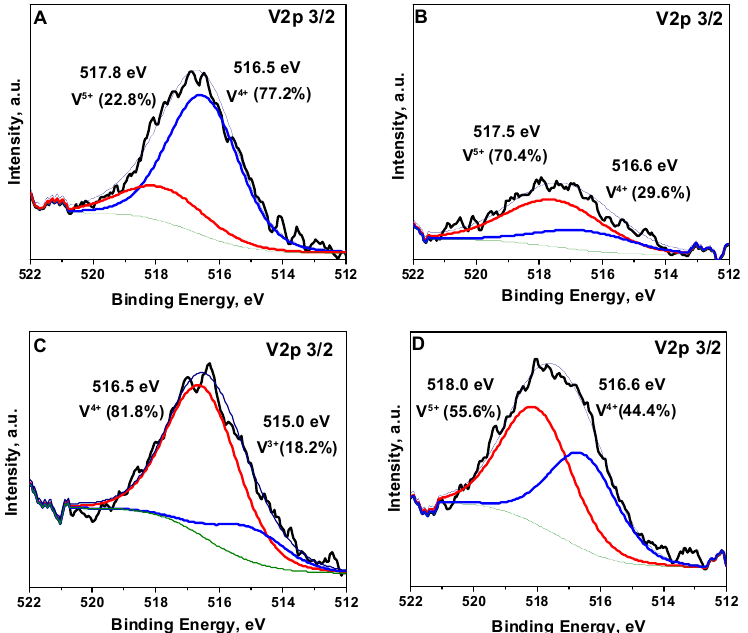
Figure 5. XP spectra of materials obtained in the V 2p region. ( A ) V S /SBA-15, ( B ) TPS/V S /SBA-15, ( C ) V M /SBA-15, ( D ) TPS/V M /SBA-15